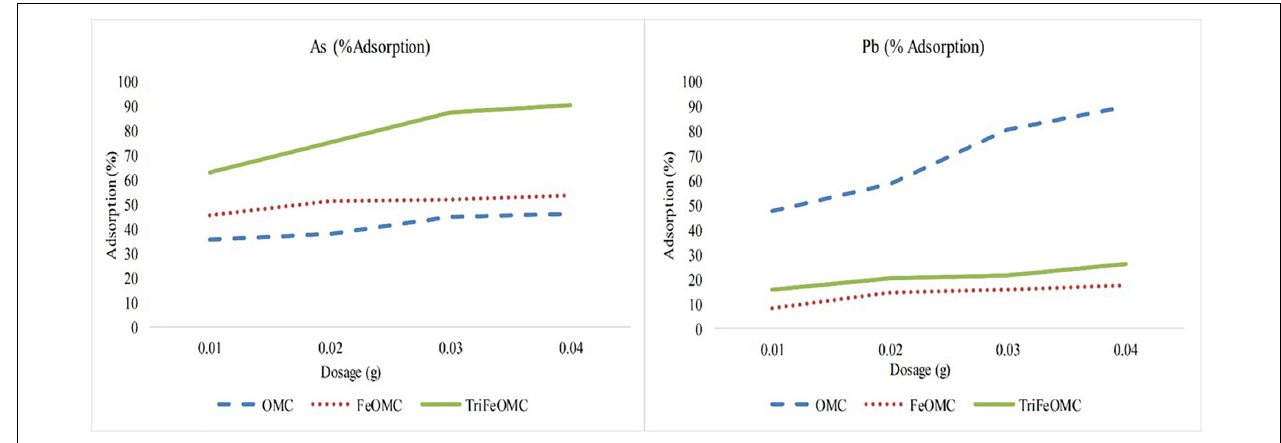
FIGURE 8 | The percent adsorption of Arsenic (As) and Lead (Pb) by OMC, FeOMC, and TriFeOMC at different dosages with constant pH = 7 and T = 25 ◦